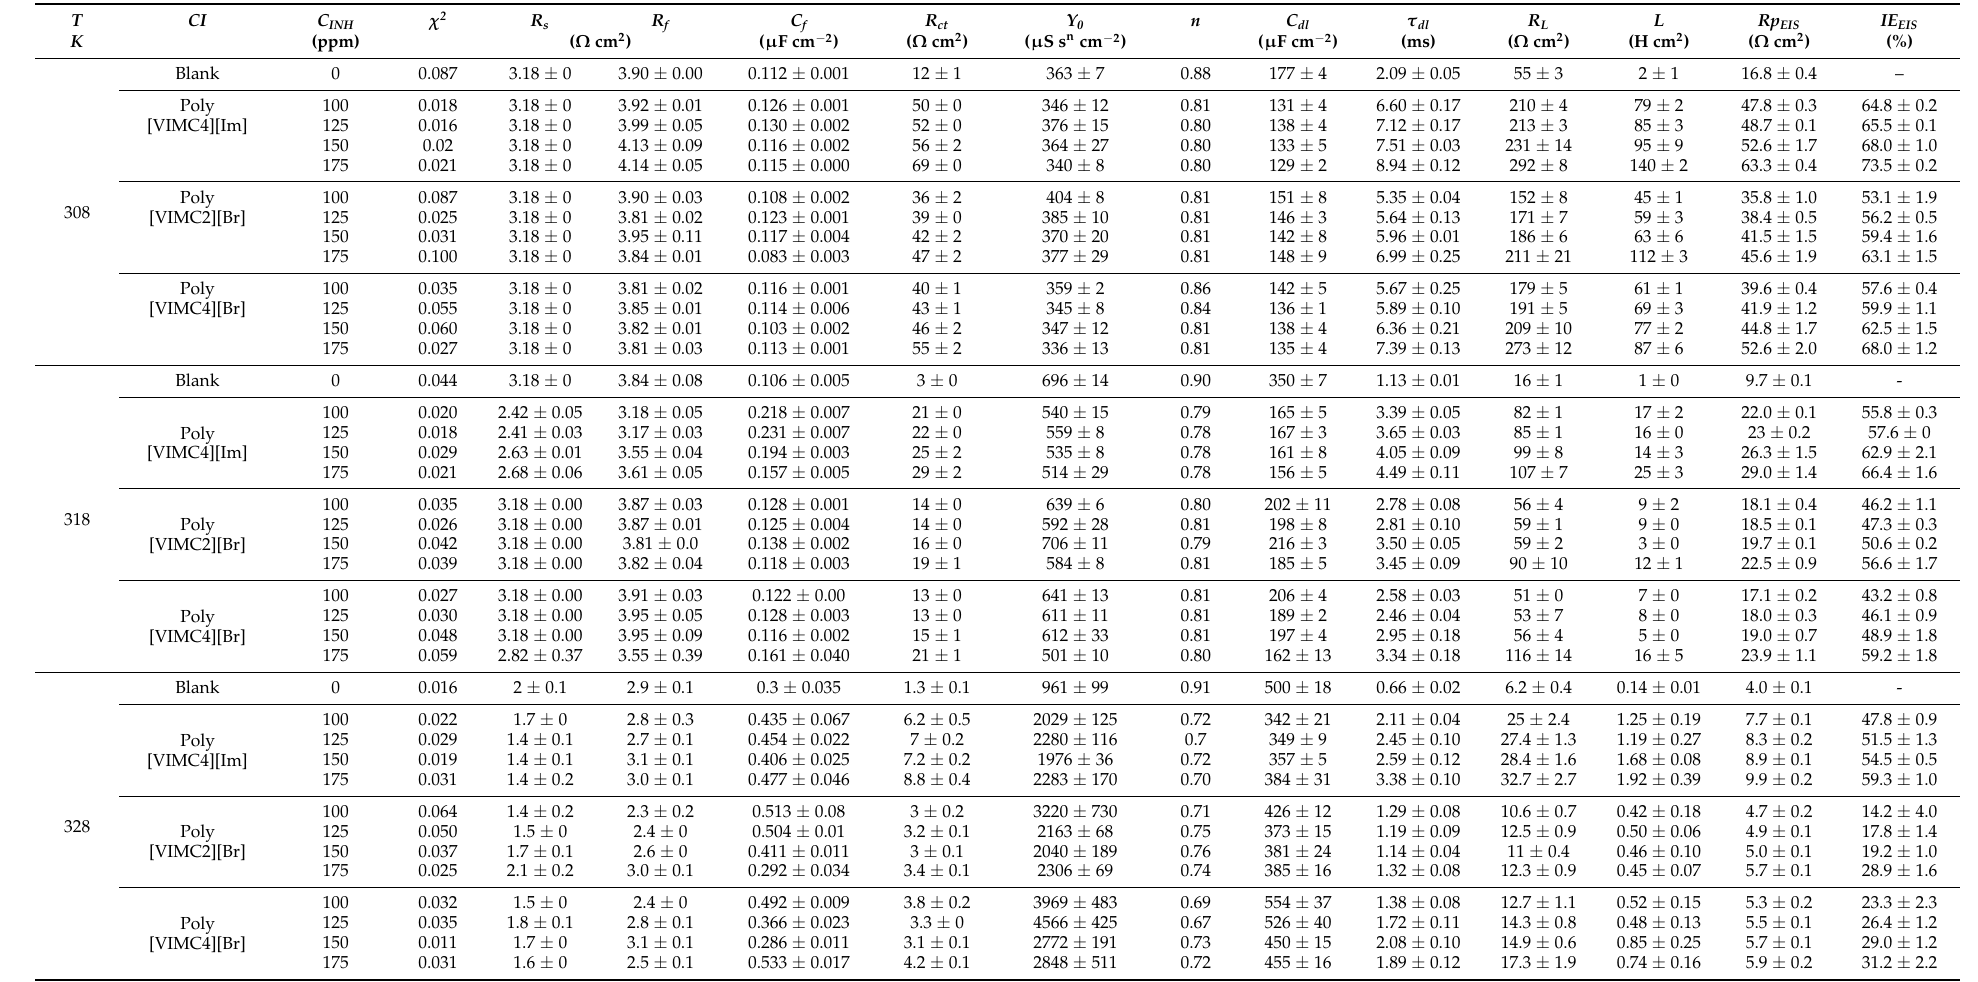
Table 4. Electrochemical parameters of API 5L X60 steel in 1 M H 2 SO 4 —CIs at different temperatures by